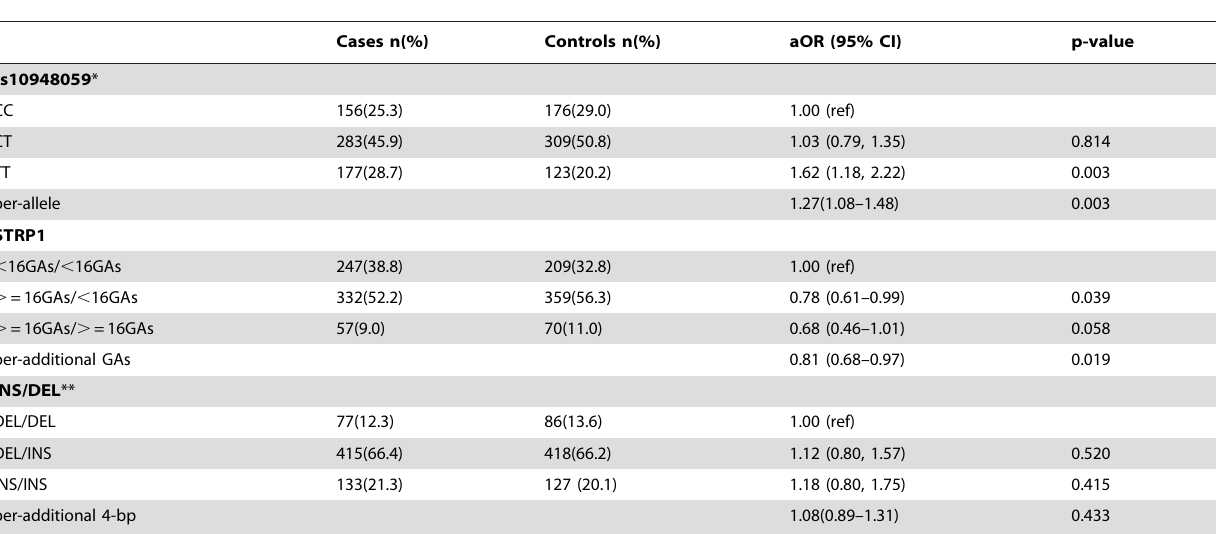
Table 2. Frequency of GNMT polymorphisms and association with prostate cancer